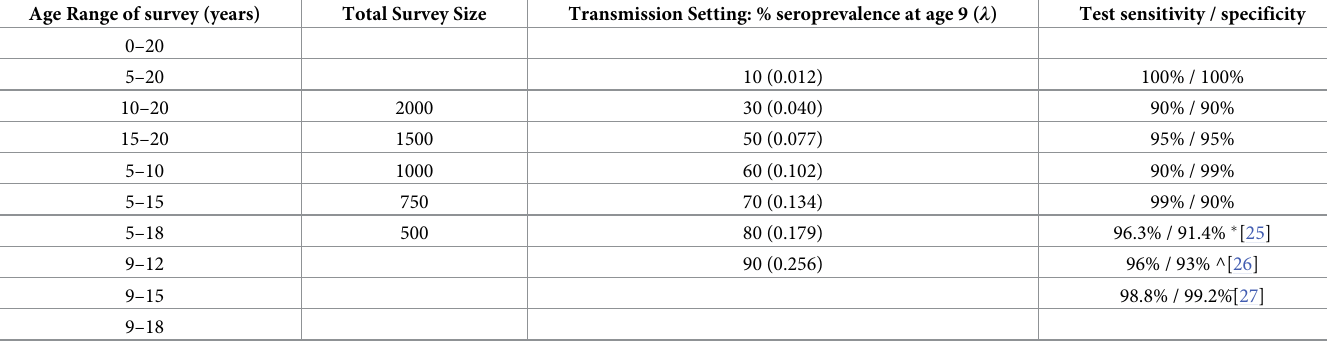
Table 1. Summary of different scenarios used for simulated seroprevalence surveys. Each variable is varied independently. The last three scenarios for the test sensitiv- ity/specificity column represent reported performance of commercial tests. Age Range of survey